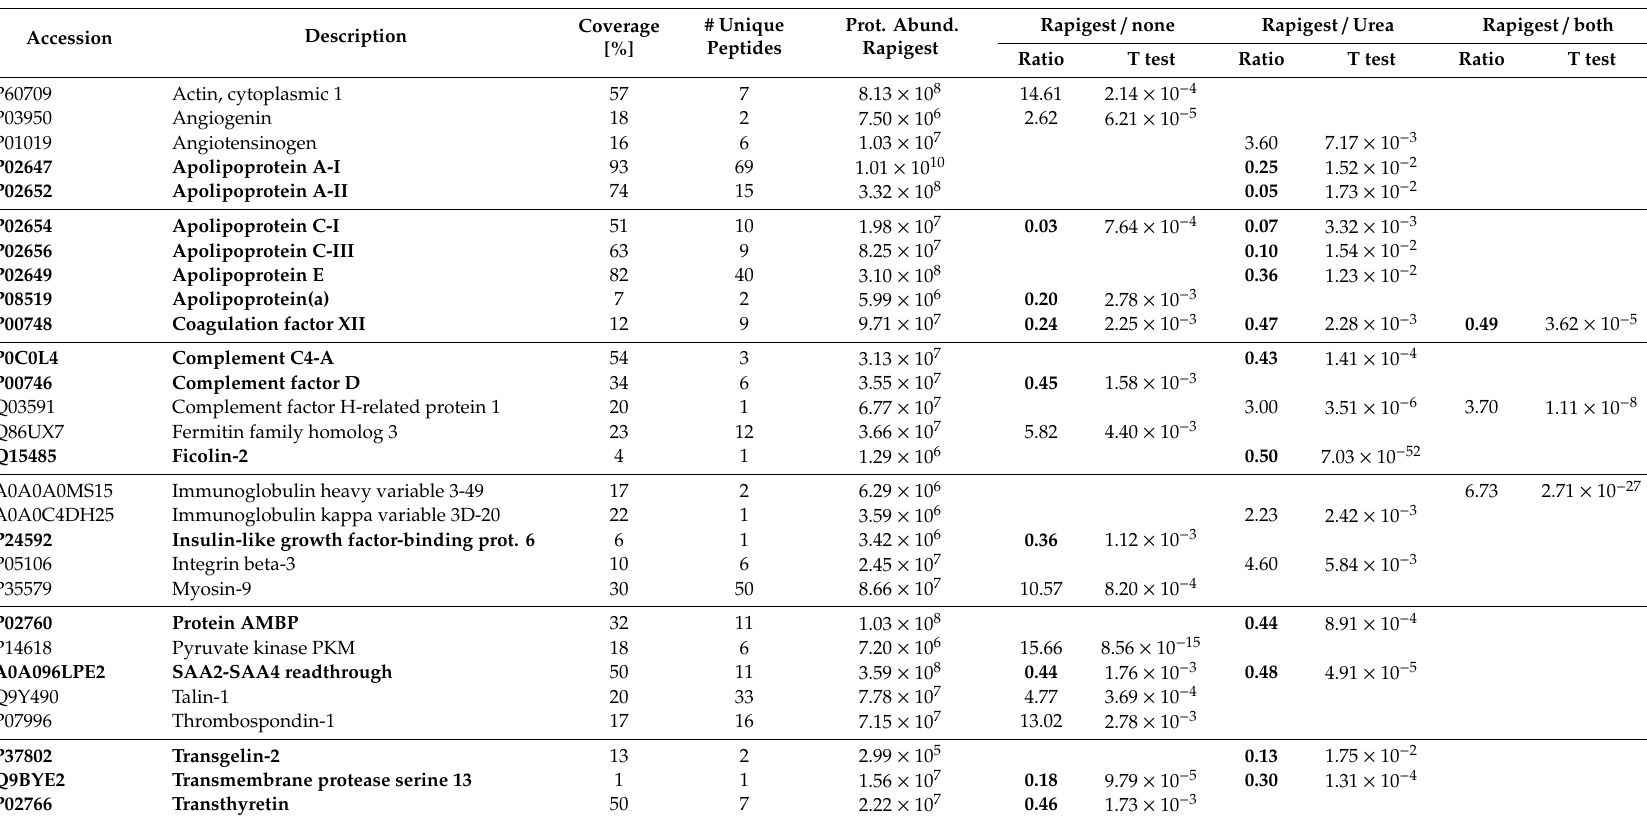
Table 1. Proteins di ff ering significantly ( p < 0.05) in their abundance (following on-bead digestion from SiO 2 NMs) depending upon the solubilizing agent used. Proteins written in bold showed a reduced abundance in the Rapigest SF ™